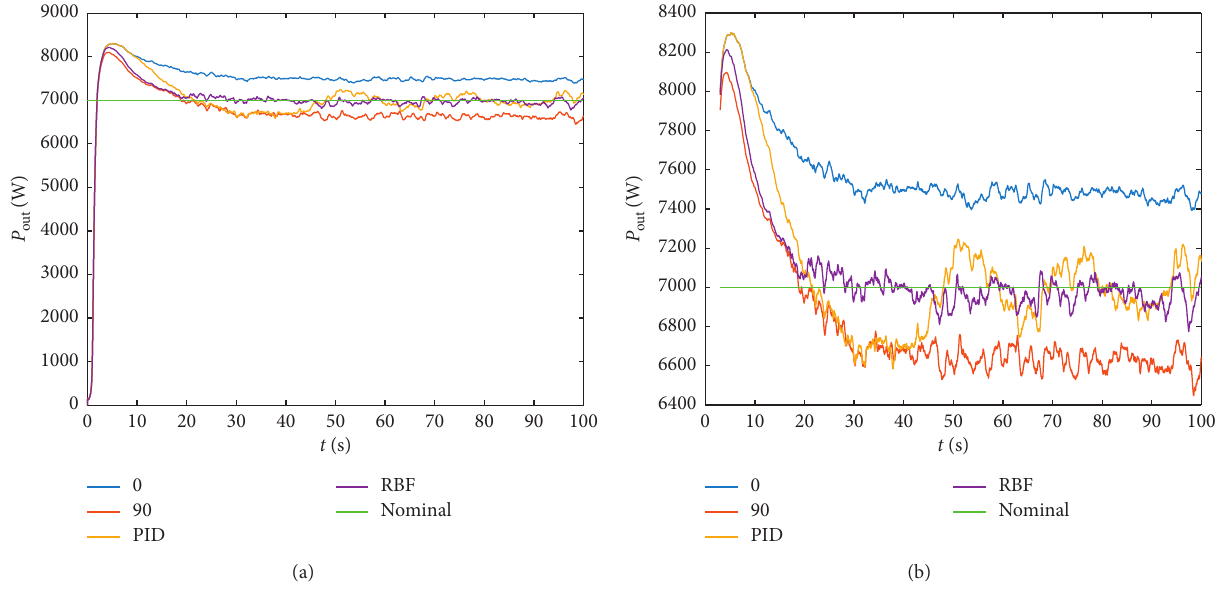
Figure 5: Output power with different strategies (a) and output power zoom (b).